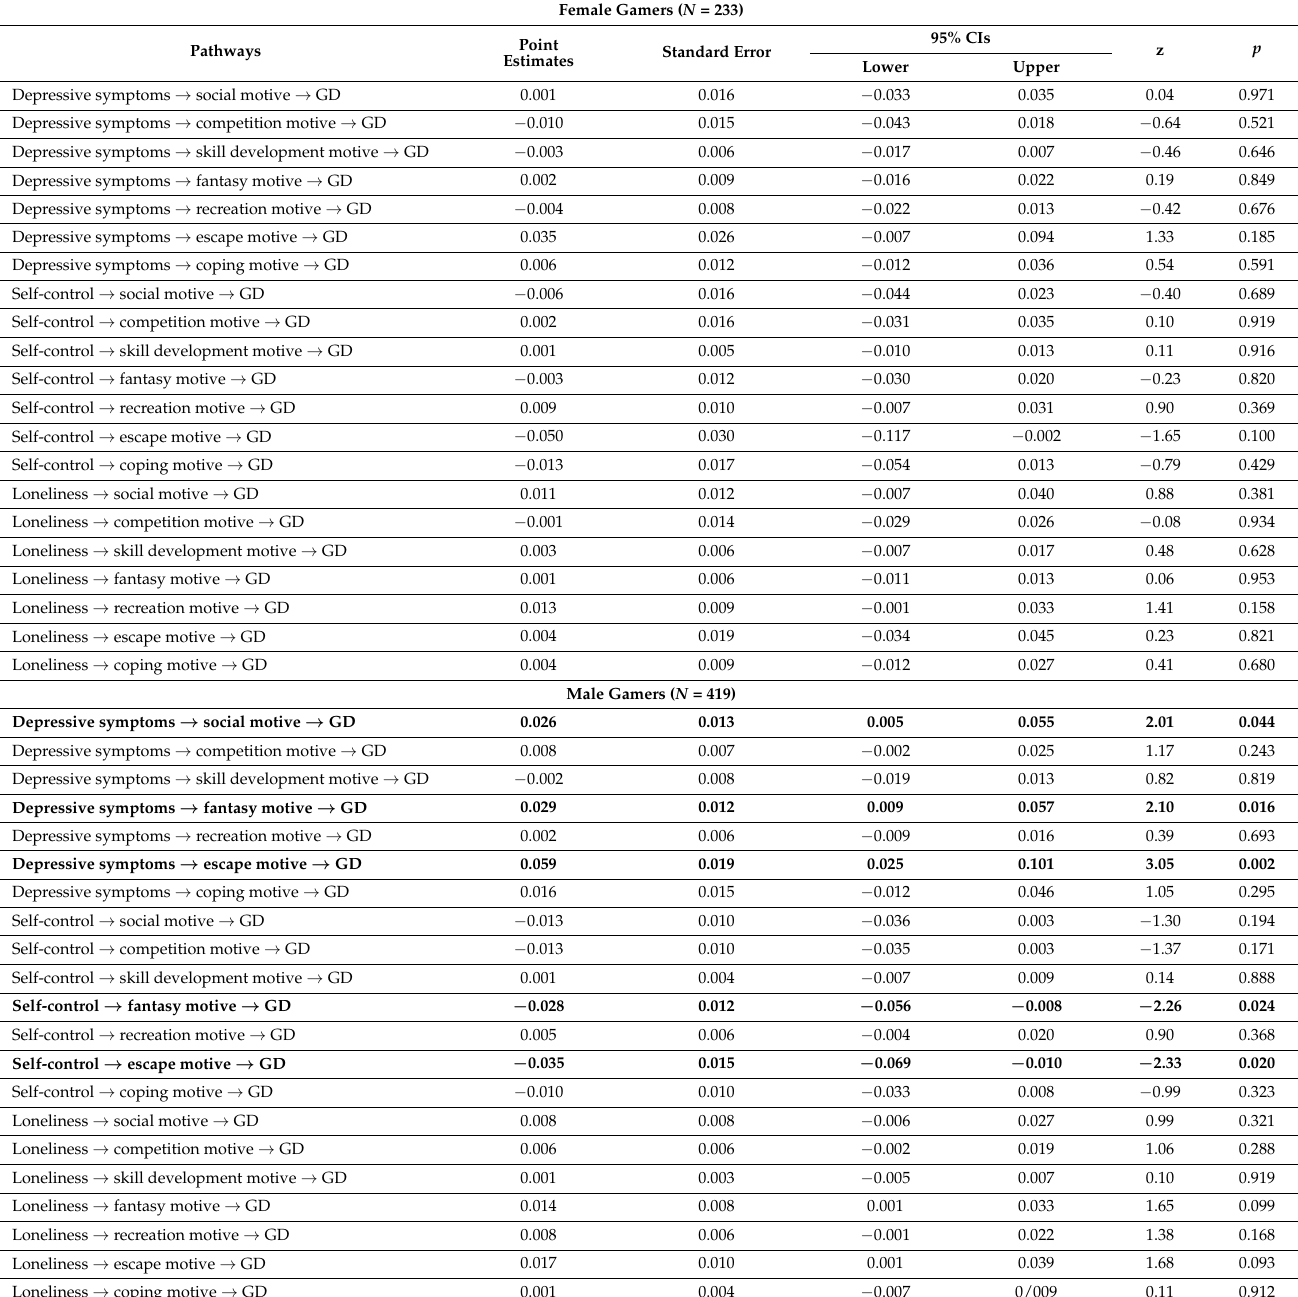
Table 4. Standardized indirect effects with 95% confidence intervals (CIs).